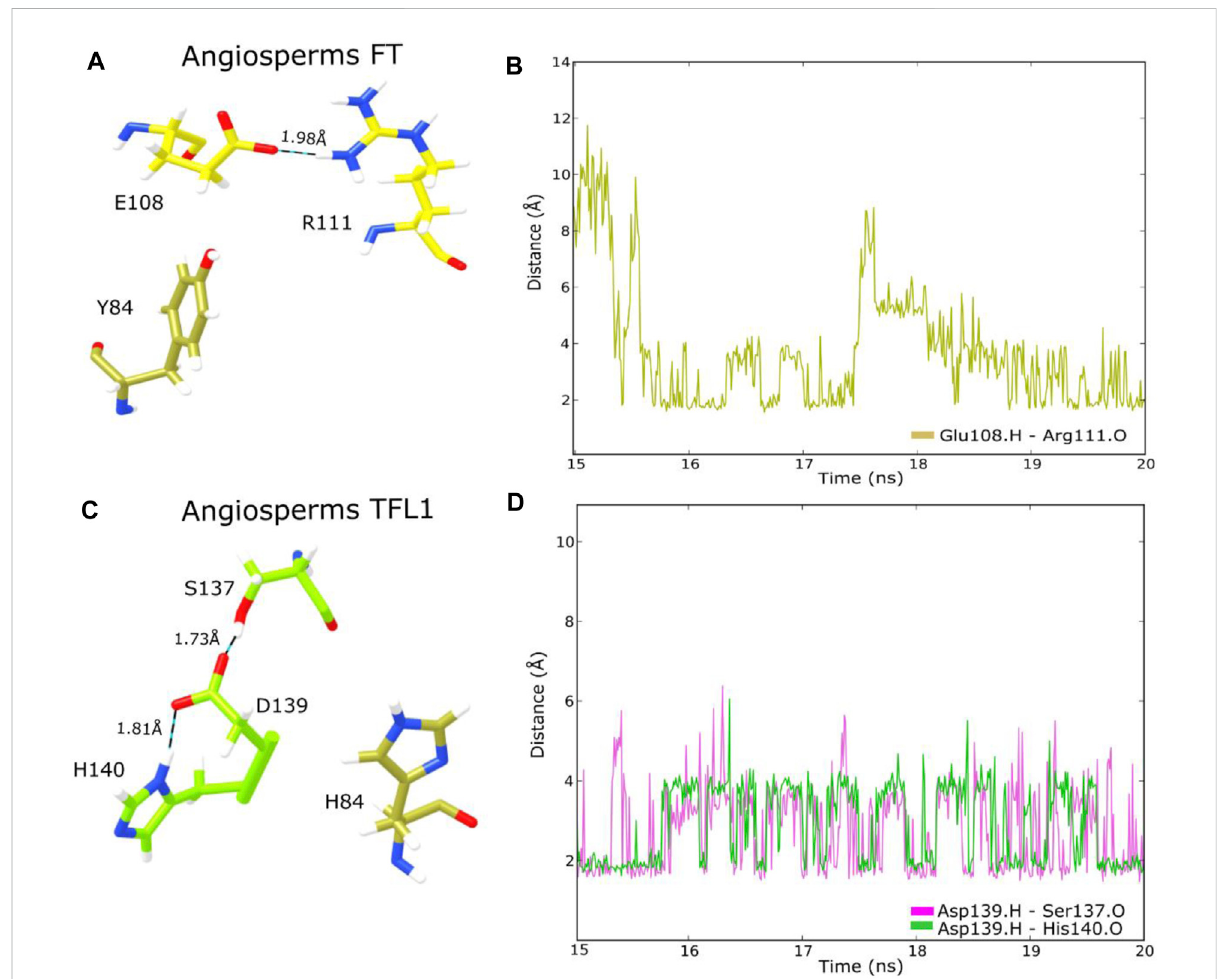
FIGURE 7 Analysis of H-bond interactions in the ancestral FT and TFL1 structures from angiosperms through MD simulation (A) Detailed overview of FT residues involved in H-bond interactions; (B) Interatomic H-bond distances veri fi ed over 20 ns of MD simulation of FT structure (C) Detailed overview of TFL1 residues involved in H-bond interactions; (D) Interatomic H-bond distances veri fi ed over 20 ns of MD simulation of TFL1